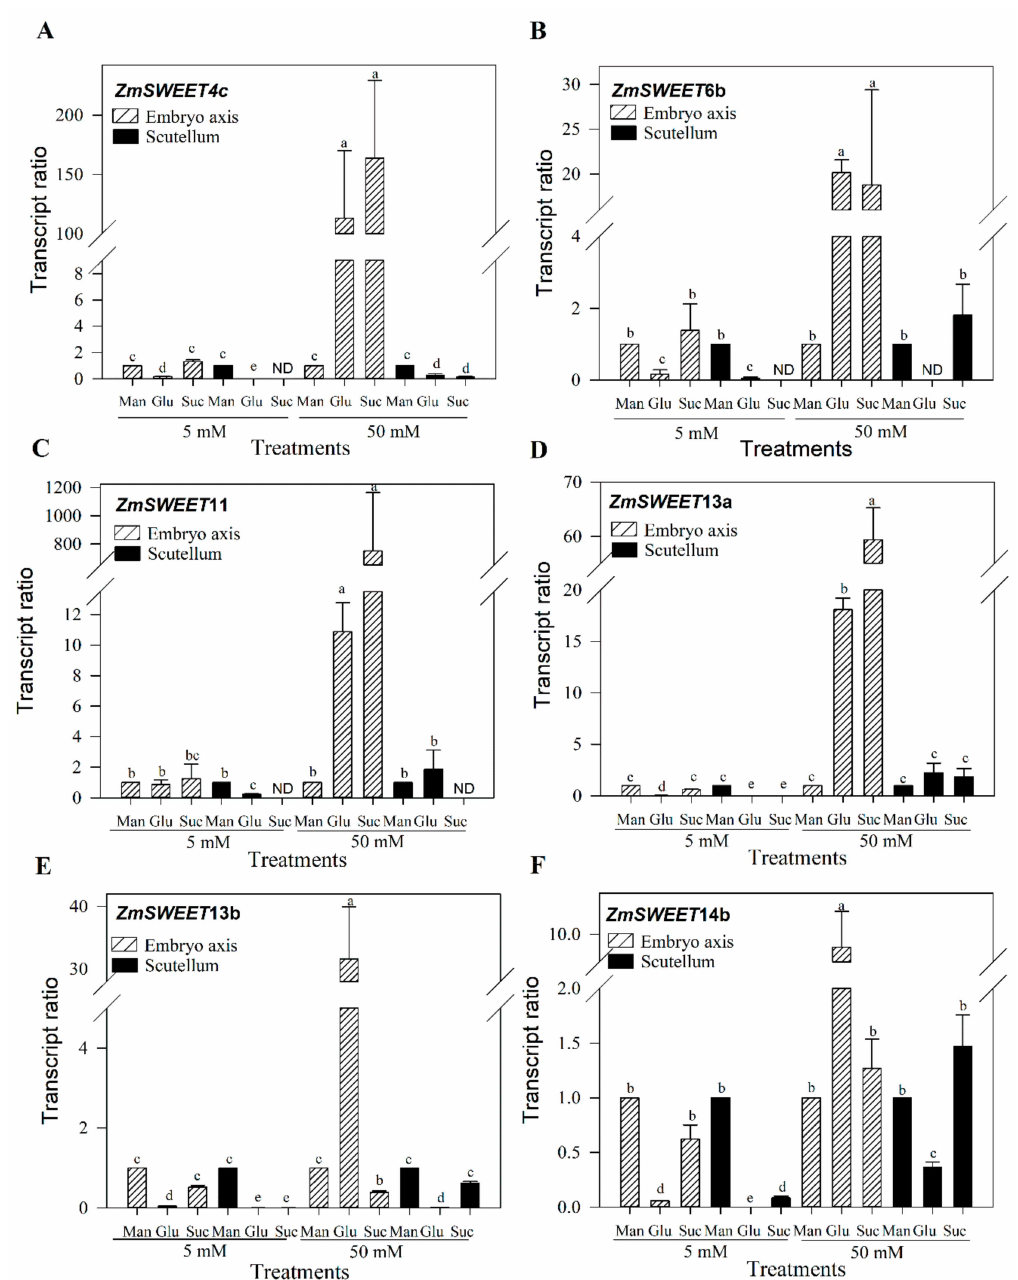
Figure 8. E ff ect of glucose, sucrose and mannitol in ZmSWEET mRNA levels in the embryo axis and scutellum. ( A ) ZmSWEET4c, ( B ) ZmSWEET6b, ( C ) ZmSWEET11, ( D ) ZmSWEET13a, ( E )